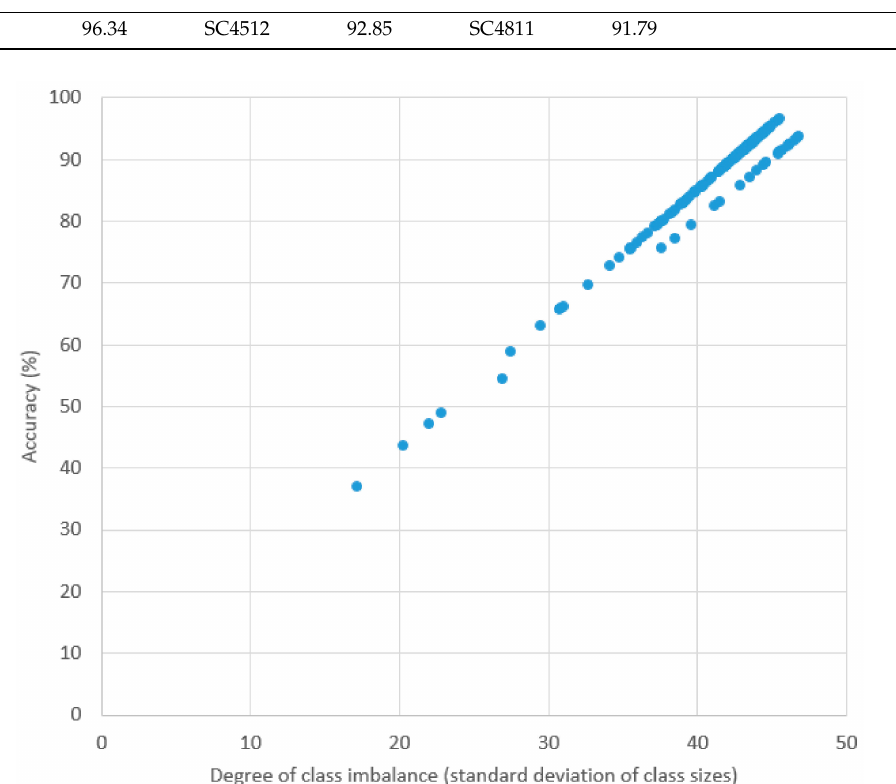
Figure 4. Plot of accuracy and standard deviation of class sizes in each